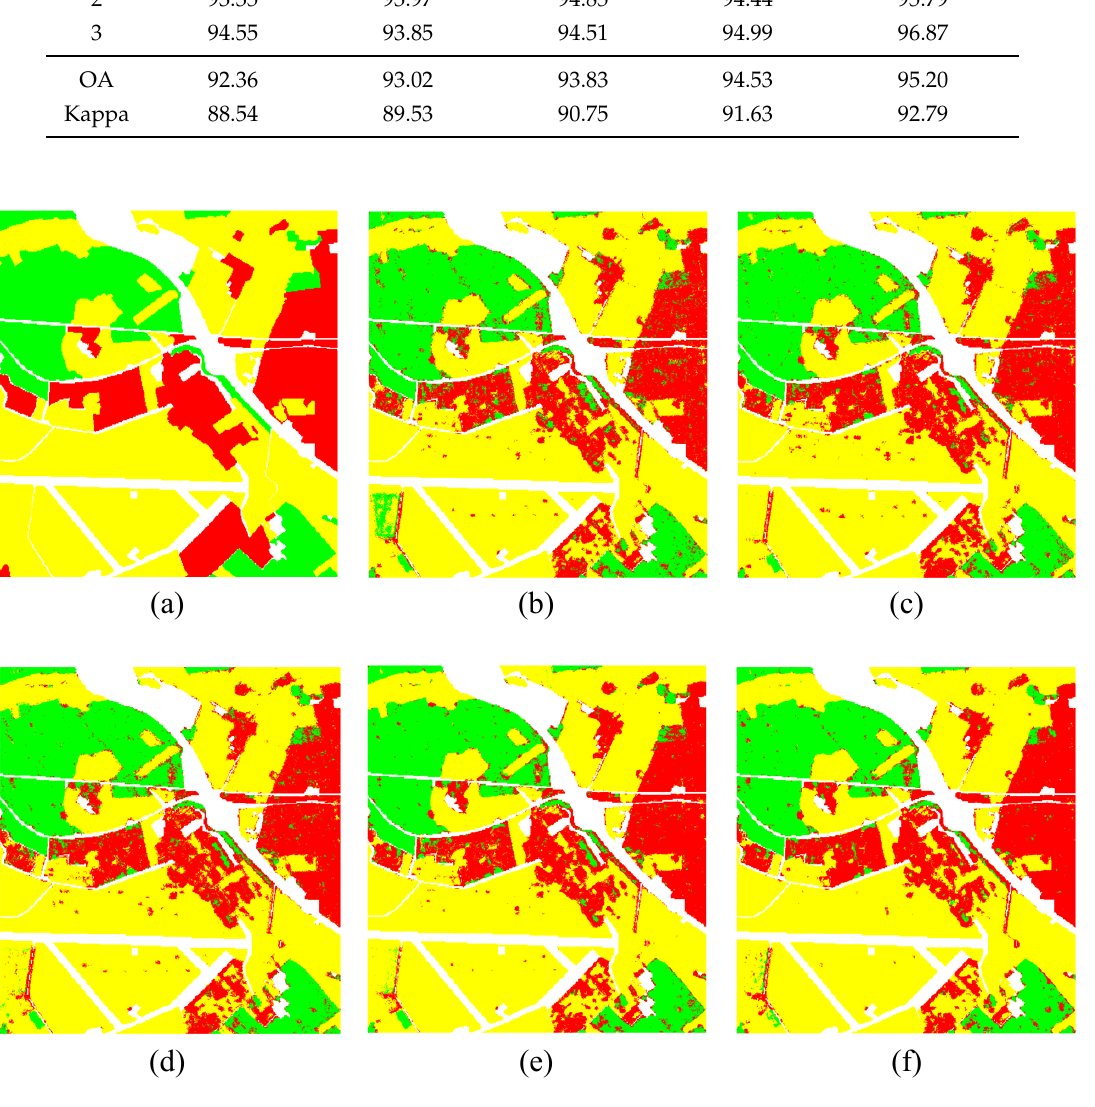
Figure 13. Classification results overlaid with the ground truth map on ESAR Oberpfaffenhofen data with different methods. ( a ) Ground truth. ( b ) Result of CNN. ( c ) Result of DW-CNN. ( d ) Result of 3D-CNN. ( e ) Result of P3D-CNN. ( f ) Result of